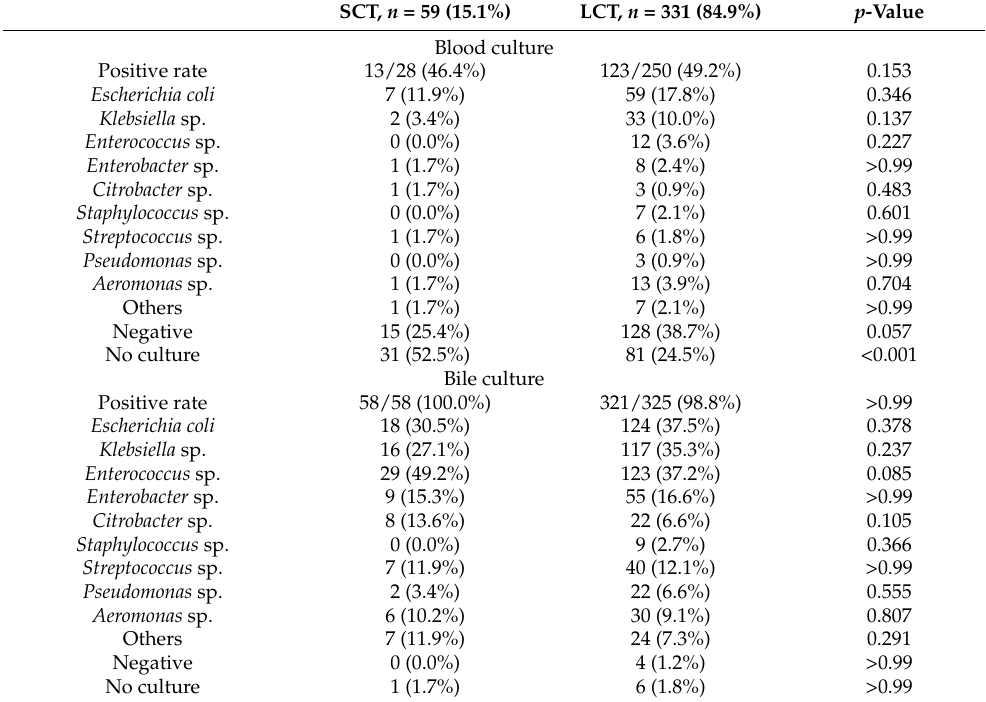
Table 3. The laboratory findings of microbial